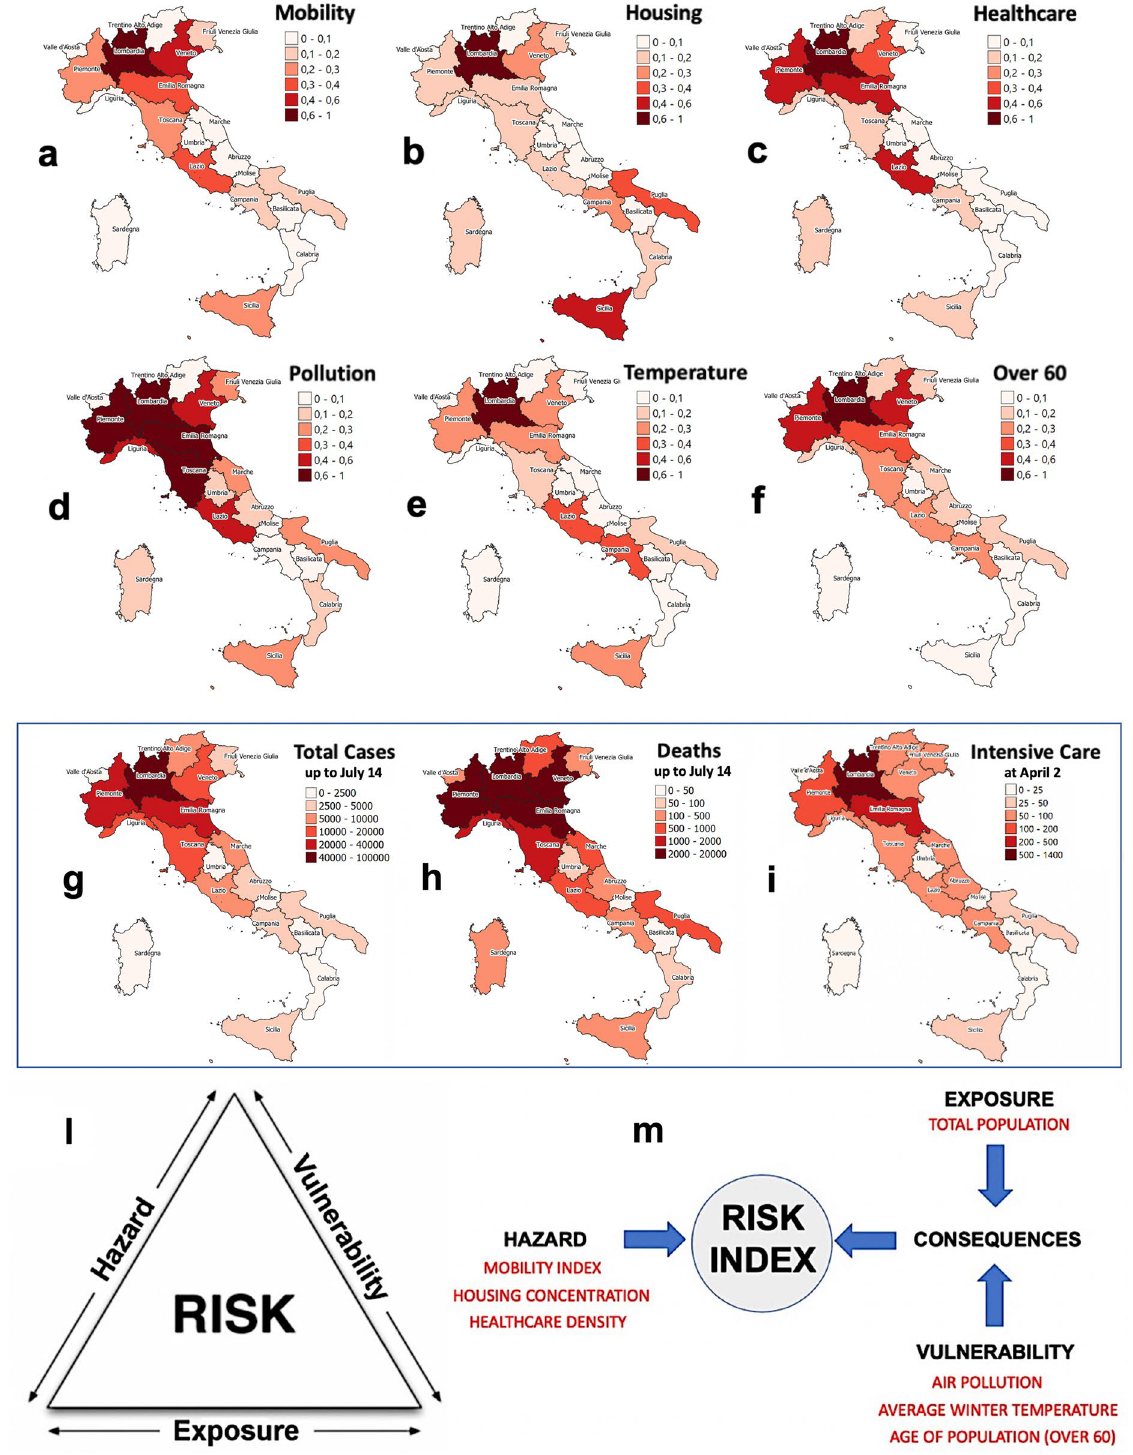
Figure 2. The geographical distribution of the six risk factors ( a – f ) can be compared with the COVID-19 total cases ( g ), the total deaths ( h ) and the intensive care occupancy ( i ). Cases and deaths have been cumulated up to July 14, 2020, i.e. at the end of the first epidemic wave; the intensive care data have been recorded on April 2, 2020, i.e. just before the epidemic peak. The risk indicators have been multiplied for the population of each region and normalized between 0 and 1 (the color scale for temperature has been reversed, i.e. dark colors mean low temperatures, see Methods). A concentration of dark colors in the northern regions is roughly visible for almost all the indicators and the correlations between the single factors and the damages range from 0.70 to 0.95. Maps were realized with QGIS 3.10 (https:// qgis. org/ en/ site/). ( l ) Crichton’s Risk Triangle. ( m ) Risk Index assessment framework: risk indicators (factors) are reported in red, risk components in